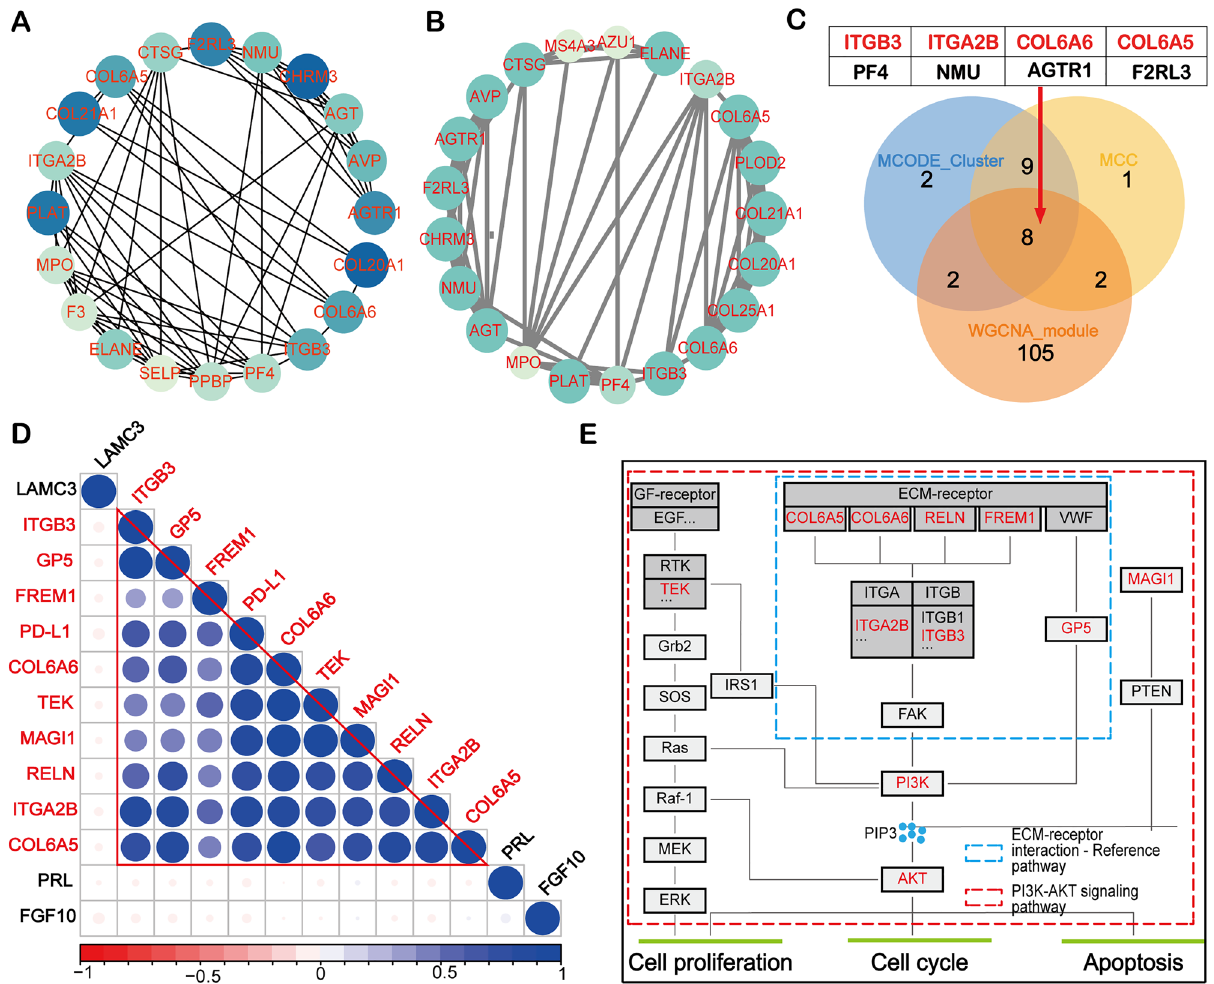
Figure 4. Identification of key PD-L1 related genes. ( A ) Protein–protein interactions (PPI) displayed the top 20 important proteins of differentially expressed genes using MCC algorithm. The color darkness indicates the importance of the protein in the network. ( B ) A key sub-network consisting of 21 nodes was constructed by the plug-in MCODE in Cytoscape. ( C ) The Venn diagram showed eight PD-L1 related genes by overlapping the WGCNA module gene set (117 genes), the MCC algorithm gene set (20 genes) and the MCODE sub-network gene set (21 genes). ( D ) Correlation analysis of PD-L1 and enriched genes in PI3K-AKT signaling pathway and ECM-receptor interaction. Blue represents positive correlation and red represents negative correlation. (E) Overall recapitulation of DEGs enriched in the ECM/PI3K-AKT signaling